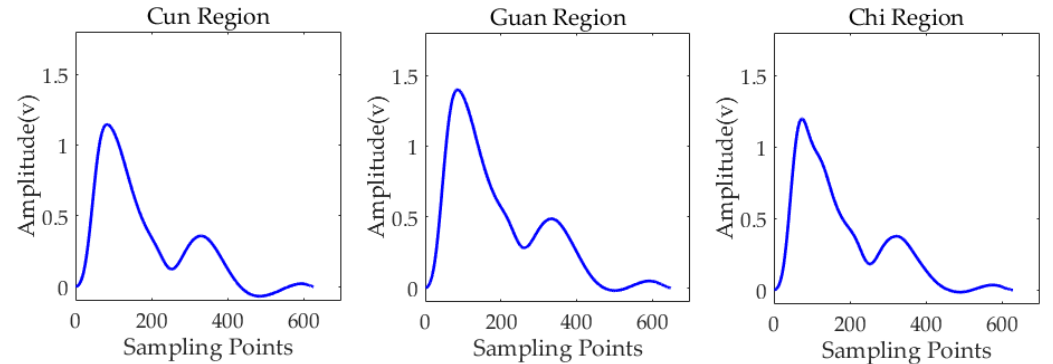
Figure 13. Single period of pulse waveforms under best pulse-taking pressure.